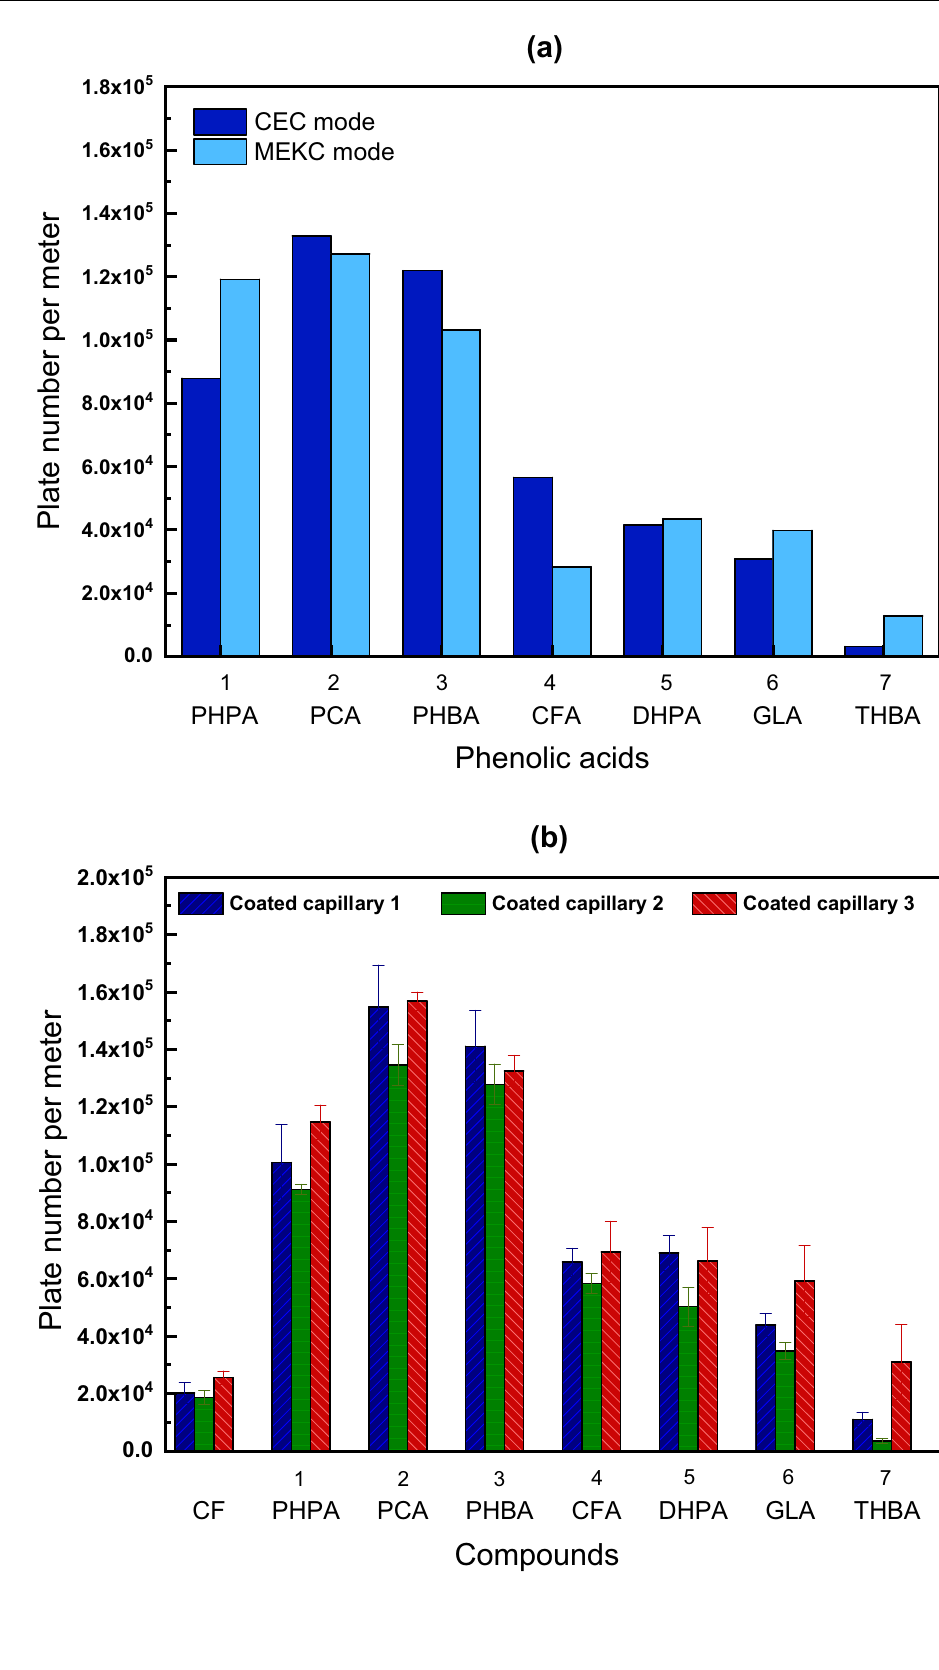
Fig. 2 Bar graphs of a plate number N per one meter of effective capillary length of the silica-layer coated capillary for CEC (dark blue) and MEKC (light blue) calculated using the peak widths of caffeine (CF) and 7 phenolic acids (PHPA, PCA, PHBA, CFA, DHPA, GLA, and THBA). b Bar graphs of plate number N per meter of the 7 phenolic acids and caffeine (CF) for three different coated capillaries. Concen- trations of the compounds are: 100 µM caffeine